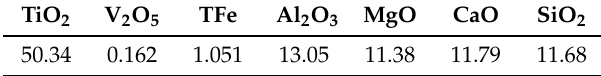
Table 4. Main composition of titanium slag (wt.